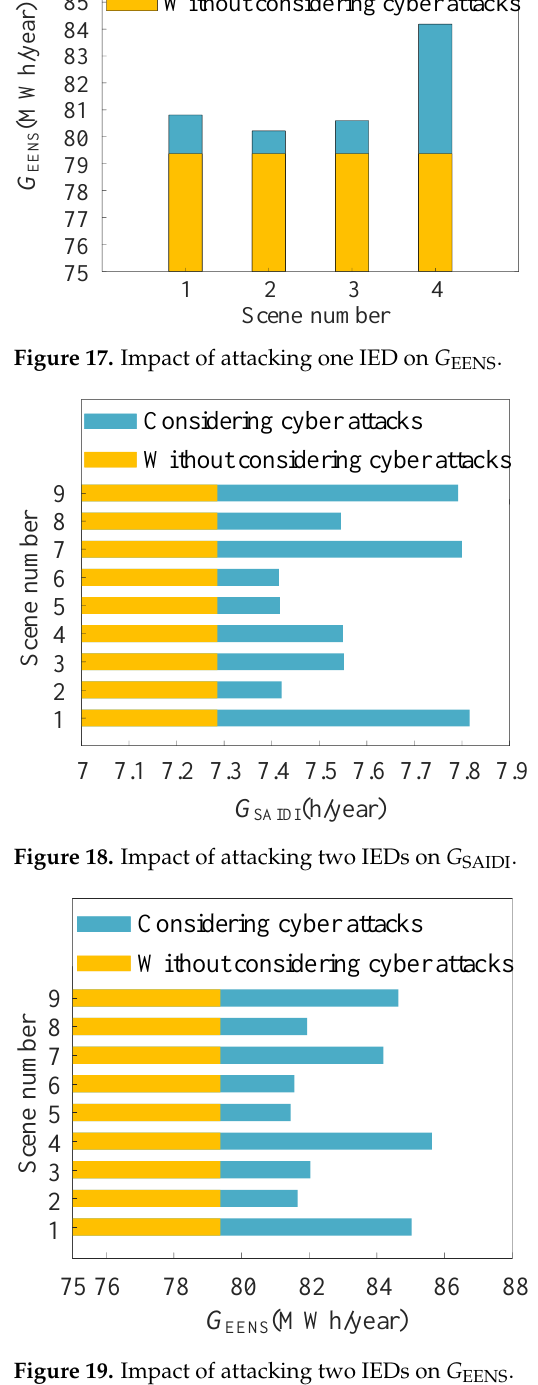
Figure 17. Impact of attacking one IED on G EENS .